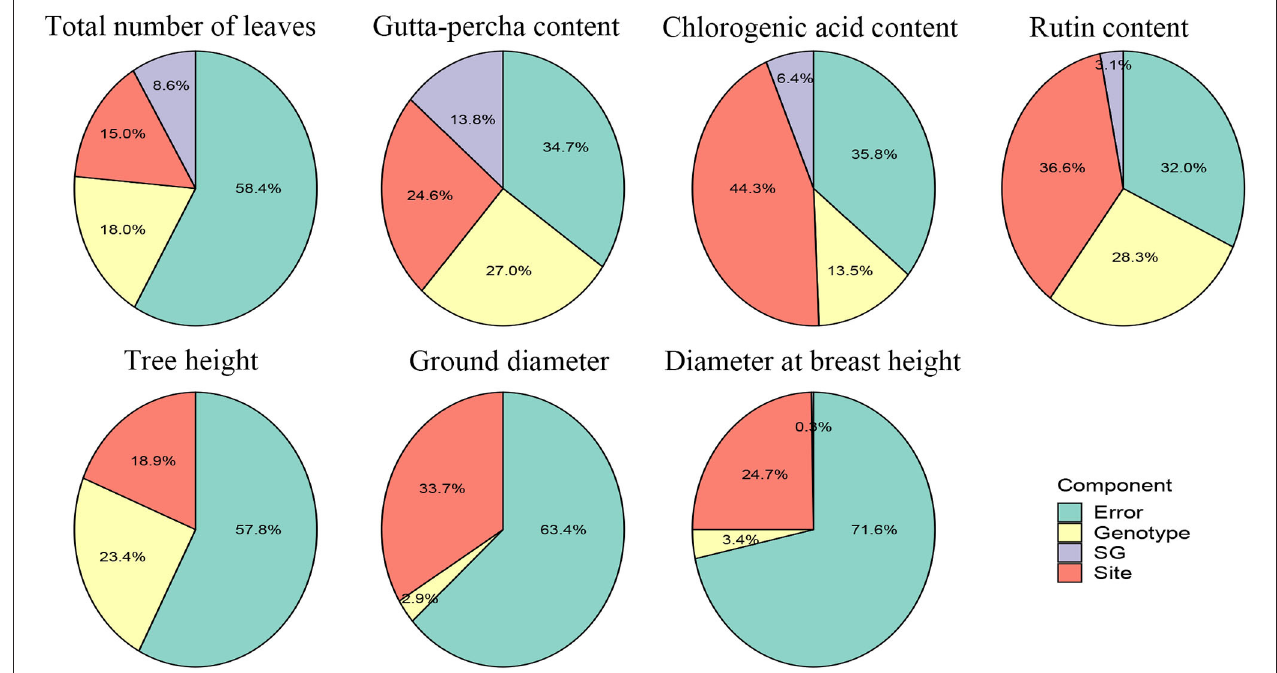
FIGURE 2 | Variance component proportions of